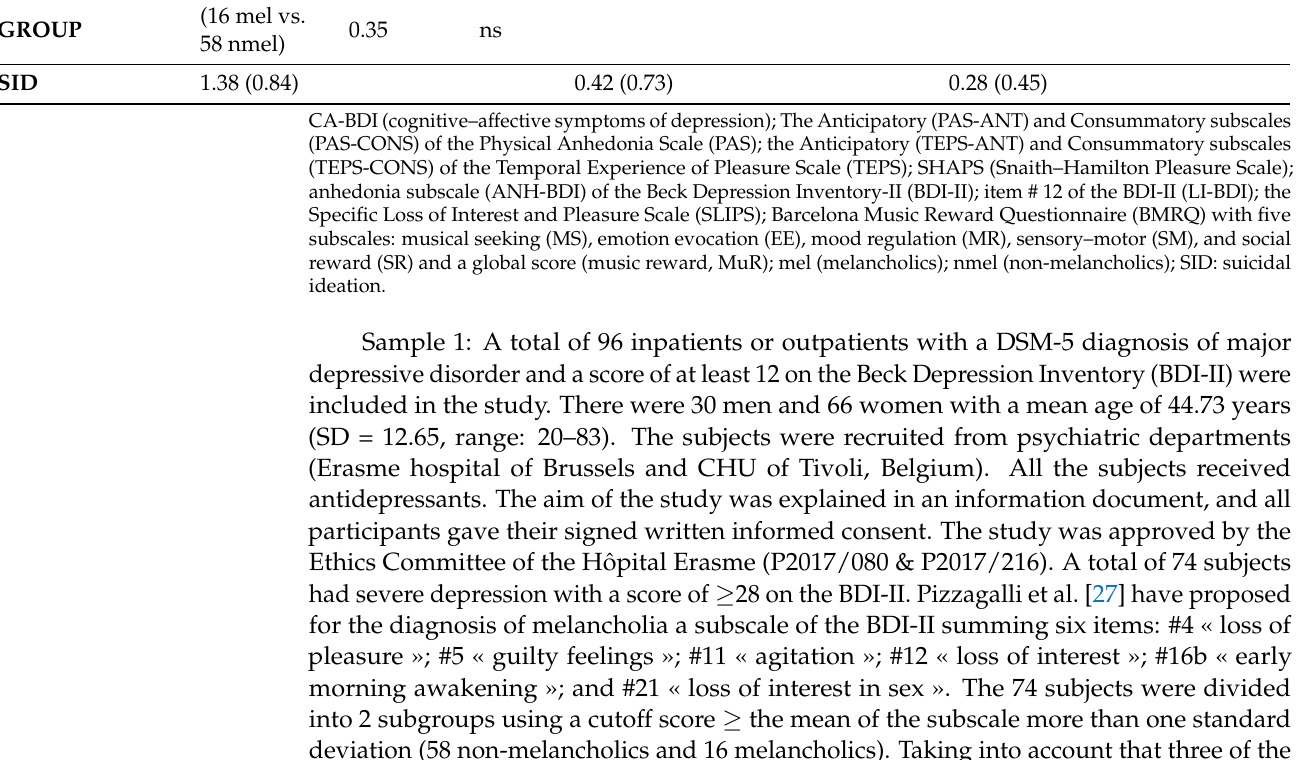
Sample 1: A total of 96 inpatients or outpatients with a DSM-5 diagnosis of